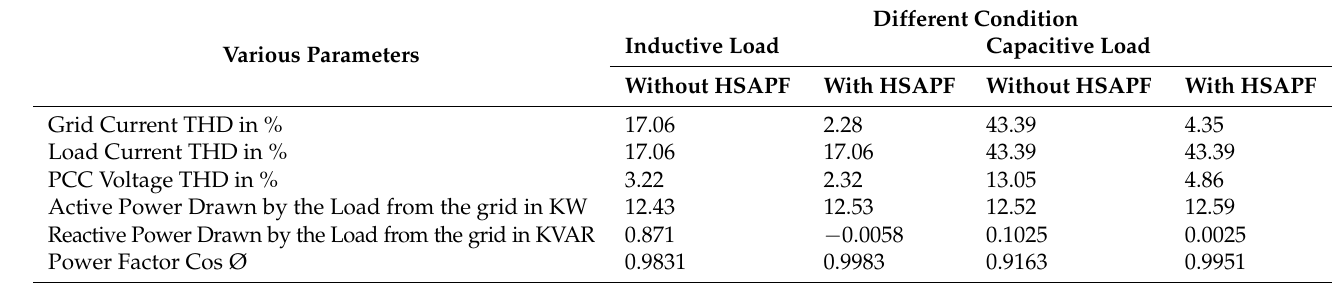
Table 2. Performance parameters obtained in simulation in grid-connected mode.